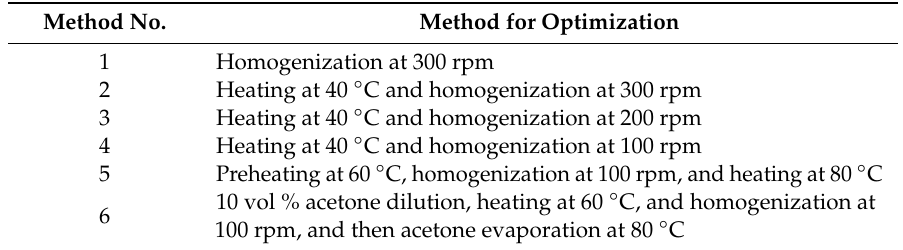
Table 4. Methods of microcapsule integration in the epoxy